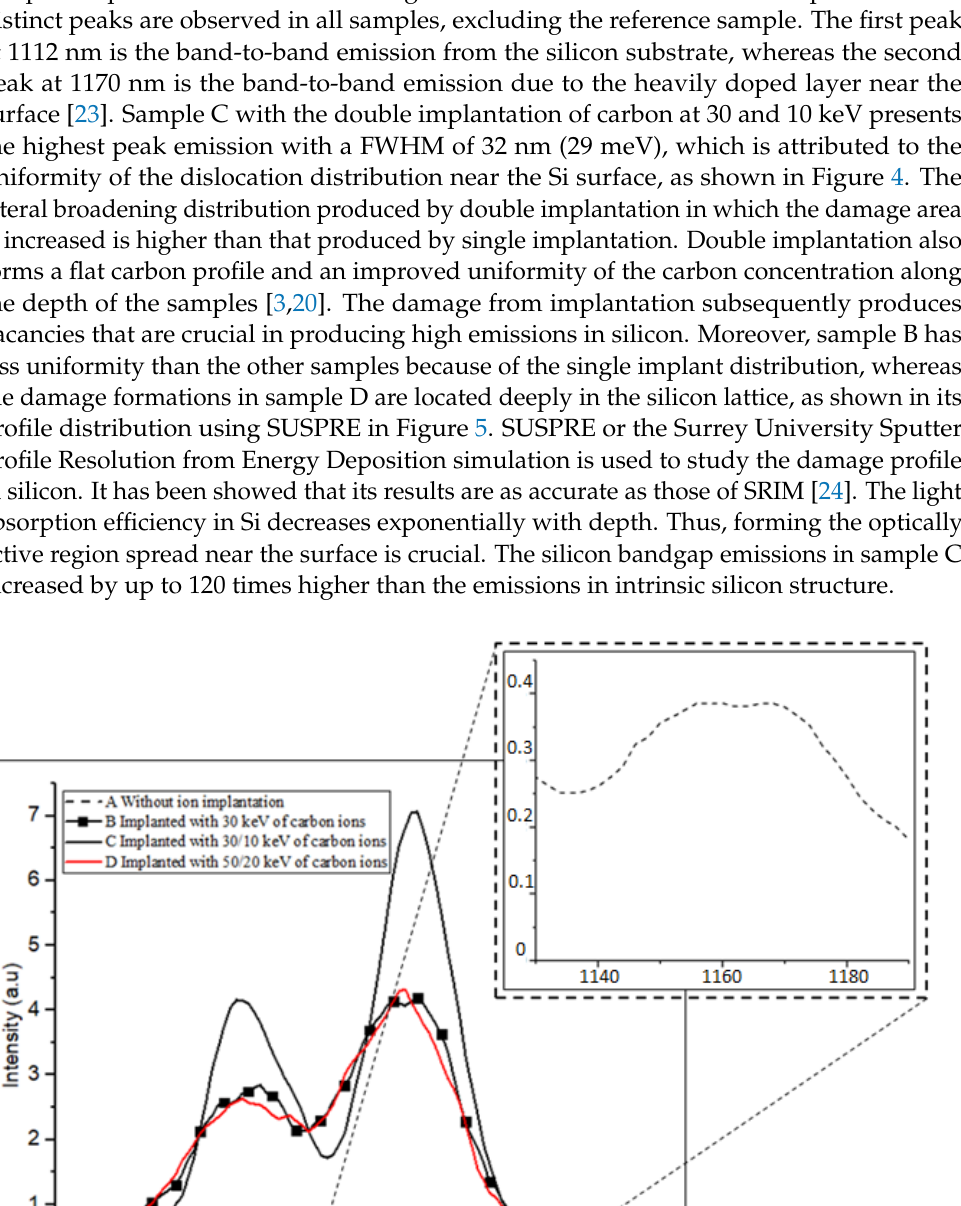
Figure 4. The carbon implantation during first implantation and second implantation. The silicon in crystal structure is bombarded with carbon ions. During the first implantation, carbon ions ran- domly fill the silicon lattice sites. The distributed substitutional carbons formed close to the surface after the second implantation are more uniform than those formed after the first implantation. Fi- nally, rapid thermal annealing is performed to activate the dopants and create the dislocation loops. Red color is carbon ion, whereas white color is interstitial. The letters ‘SURFACE’ denotes the sur- face of the silicon substrate.